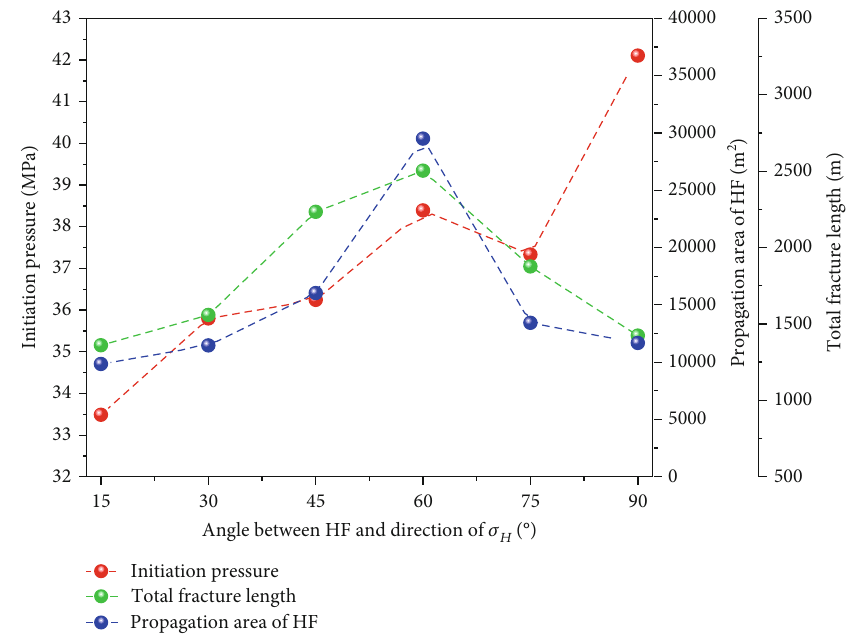
Figure 11: Total equivalent hydraulic fracture length and propagation area of the complex fracture